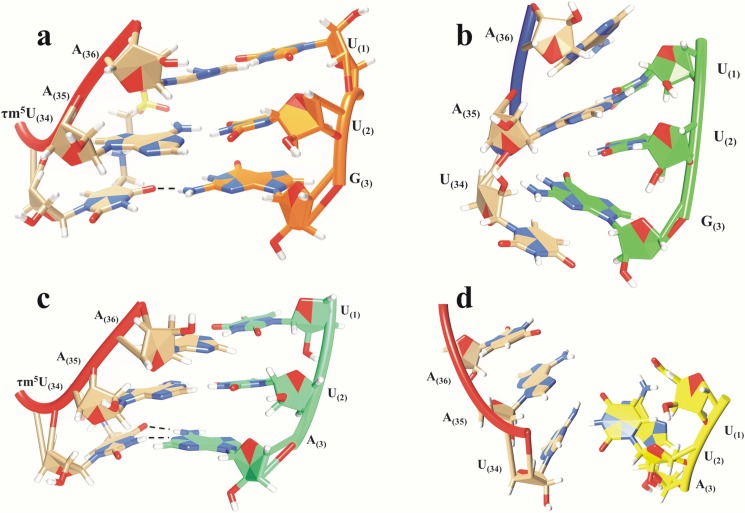
The 50ns snap shot structures showing hydrogen bonding and base stacking interactions between ASL and codon.a) model i) tRNALeu with modification τm5U:UUG codon b) model ii) tRNALeu without modification τm5U:UUG codon c) model iii) tRNALeu with modification τm5U:UUA codon d) model iv) tRNALeu without modification τm5U:UUA codon.